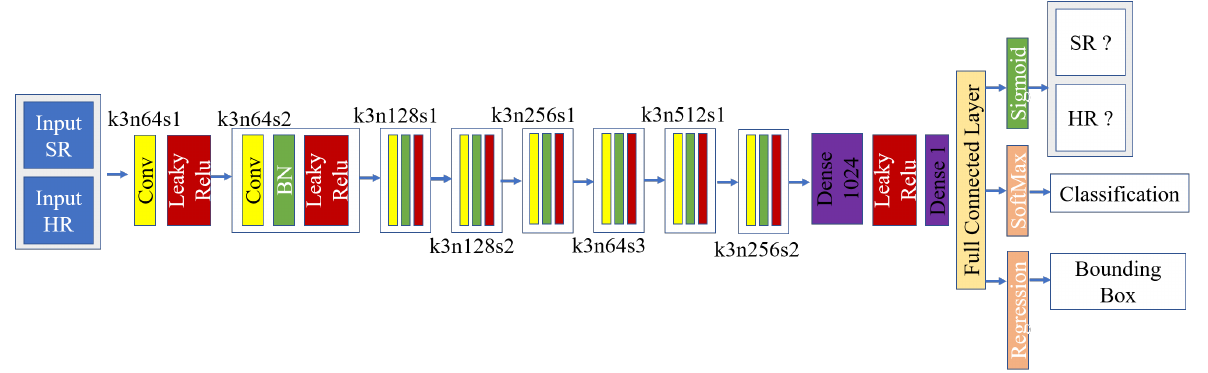
Figure 5. Discriminator Model Structure: For example, k3n64s1 stands for a conv layer with kernel size of 3, 64 feature map, and a stride of